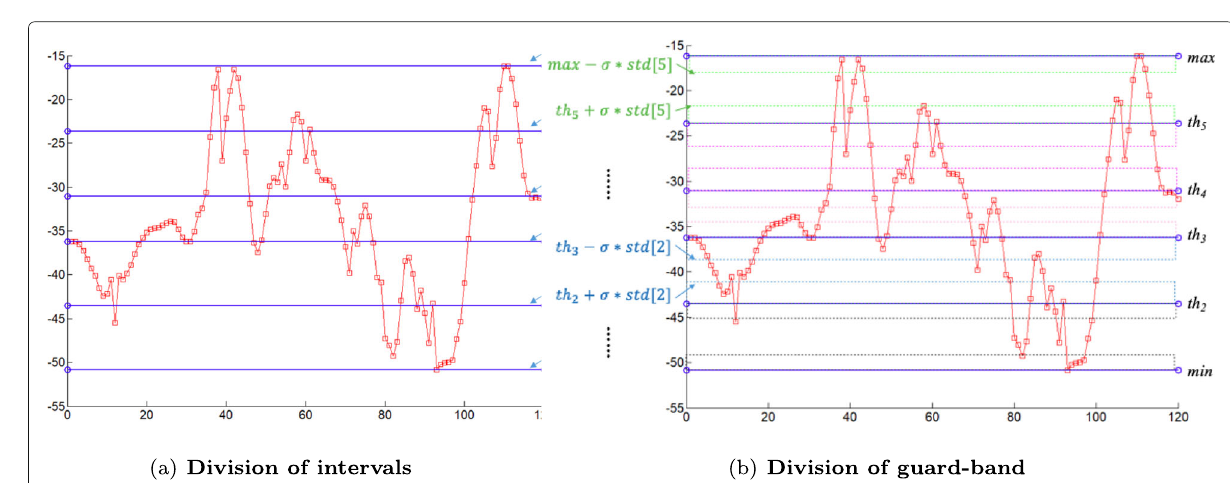
Fig. 6 Basic principles of step 1 and